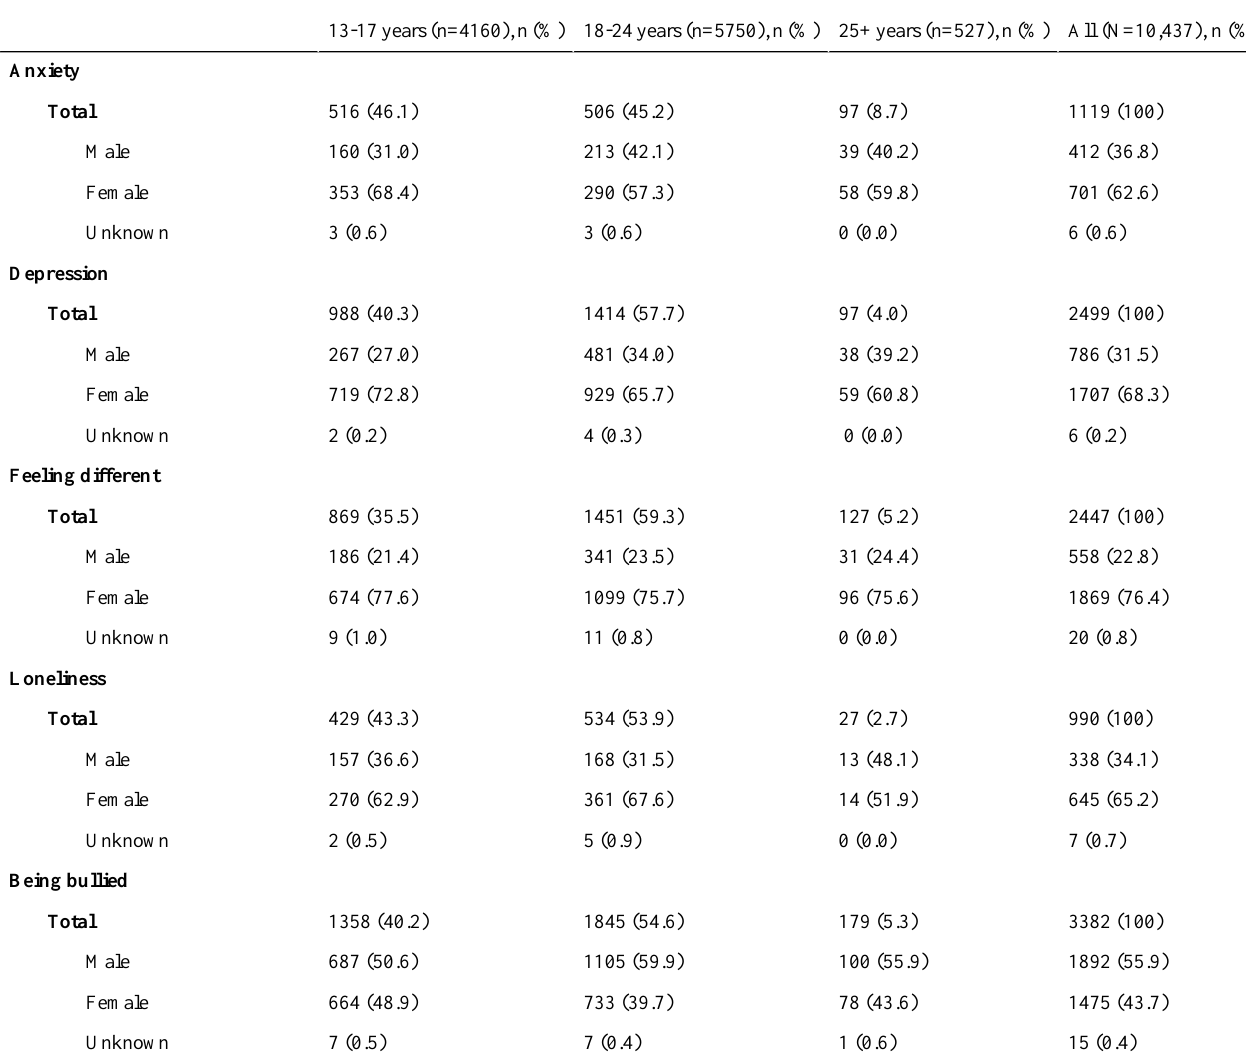
Table 2. Age and gender of viewers on the SpunOut Facebook platforms from May 9, 2019 to May 8, 2020. Age